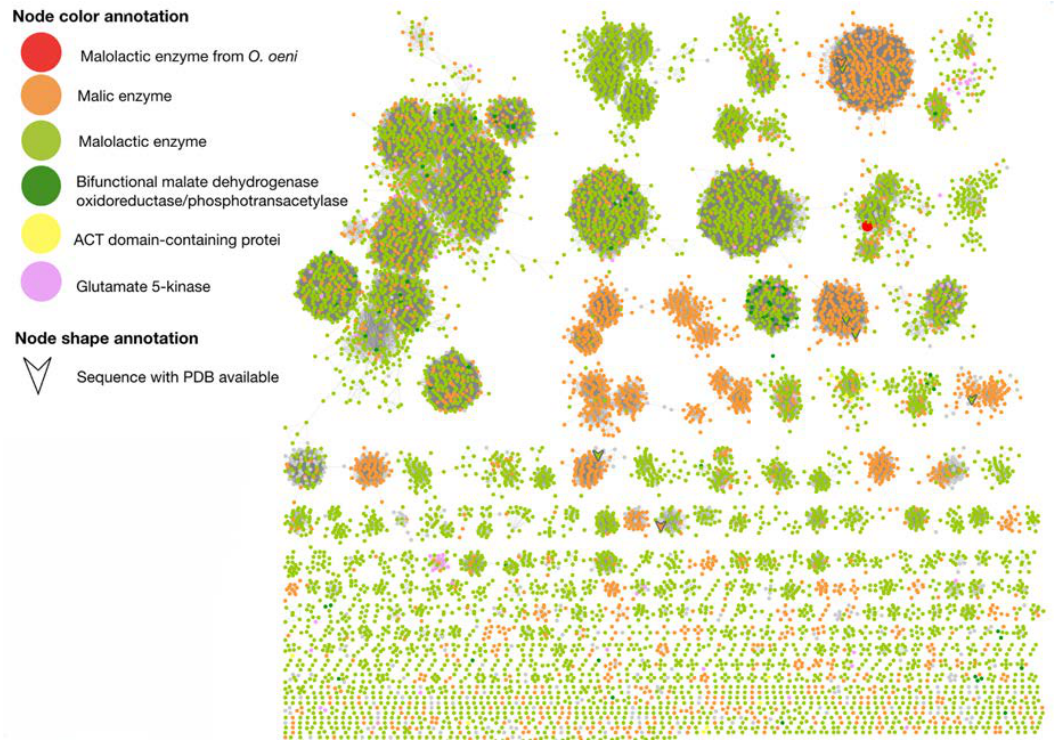
Figure 4. Sequence Similarity Network (SSN) of potential homologs to MLE of O. oeni with at least 70% identity of sequences. The nodes represent proteins and edges indicate similarity in amino acid sequence. Clustering by sequence identity is done with CD-HIT program. At values of sequence identity >70%, the nodes should contain sequences that share the same function; however, at lower values of sequence identity, the nodes may be functionally heterogeneous.